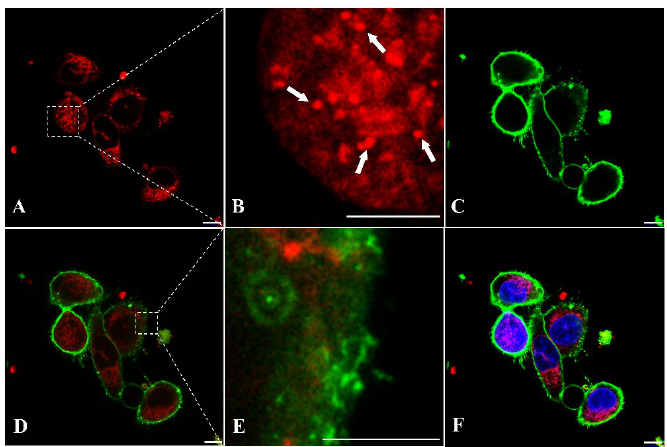
Figure 9. Fluorescence confocal imaging of anti-NELL1 aptamer-specific binding in RH30 sarcoma cells for binding colocalization analysis. The RH30 sarcoma cells were incubated with ( A ) PE-labeled AptNCan3 for overnight, ( B ) magnified image of the region of interest (ROI) box in A, the white arrows showing the small punctate structures, followed by ( C ) staining with CellBrite ® Green Membrane Staining. ( D ) merged images of A and C, ( E ) magnified image of the region of interest (ROI) box in D, and ( F ) merged images of D and the nucleus stained with DAPI. The cells were then thoroughly washed and fixed with 4% PFA before imaging. Scale bar, 10 µm.